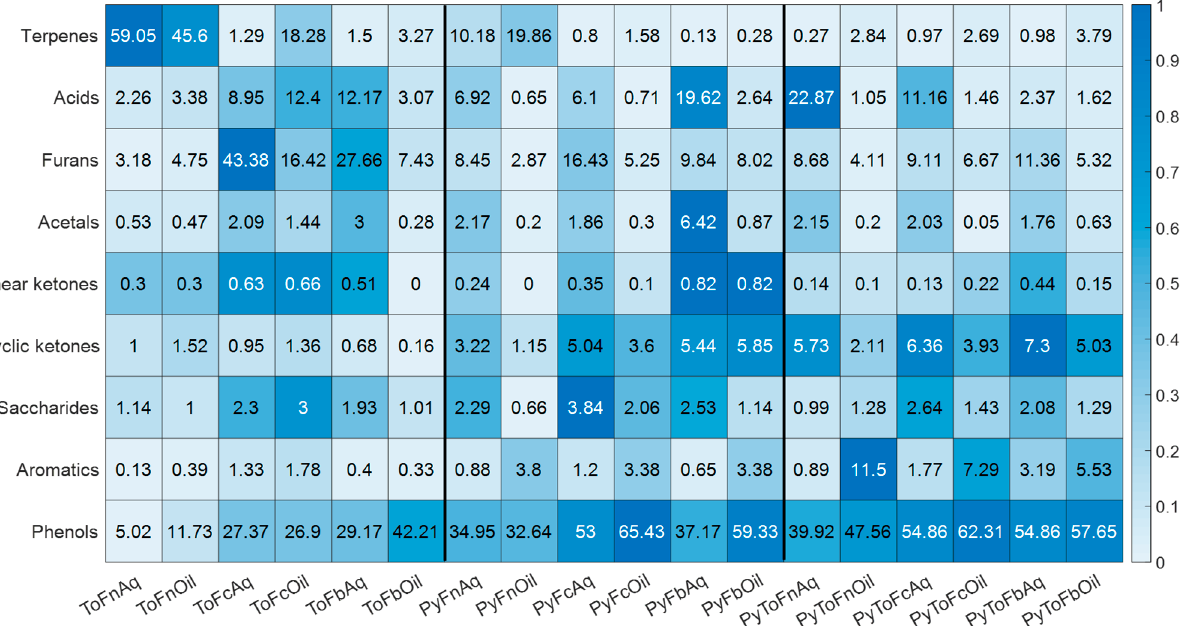
Figure 9. The heatmap representing the composition (±3% associated error) of aqueous and oil fractions from torrefaction and/or pyrolysis of fir needles, cones and bark, expressed in terms of main classes of compounds.